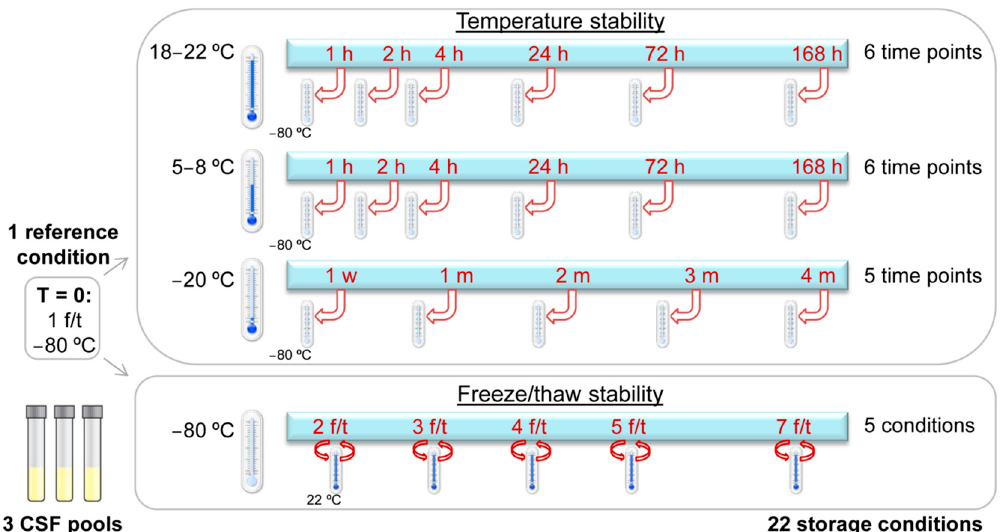
Figure 1. Overview of the di ff erent storage conditions analyzed to assess the temperature and freeze / thaw stability of small-molecule metabolites in cerebrospinal fluid. Three pools of cerebrospinal fluid were analyzed. For each pool, one reference sample and 22 samples for the di ff erent storage conditions were analyzed. Abbreviations: CSF: cerebrospinal fluid, f / t: freeze / thaw cycle, h: hours, m: months, w: week.